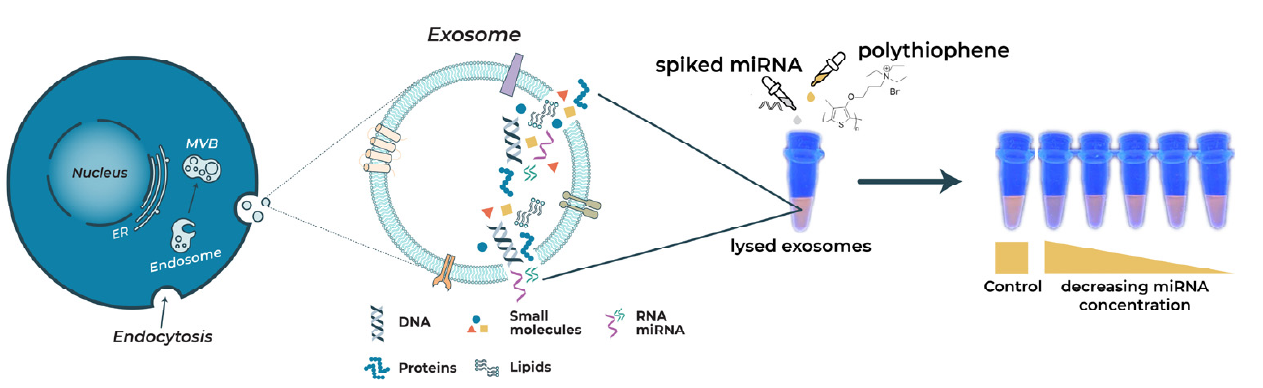
Figure 1. Exosome extraction from human plasma and lysis to release target molecules. Colorimetric responses of PT upon the addition of PNA and various concentrations of the mir21-spiked exo- somes.